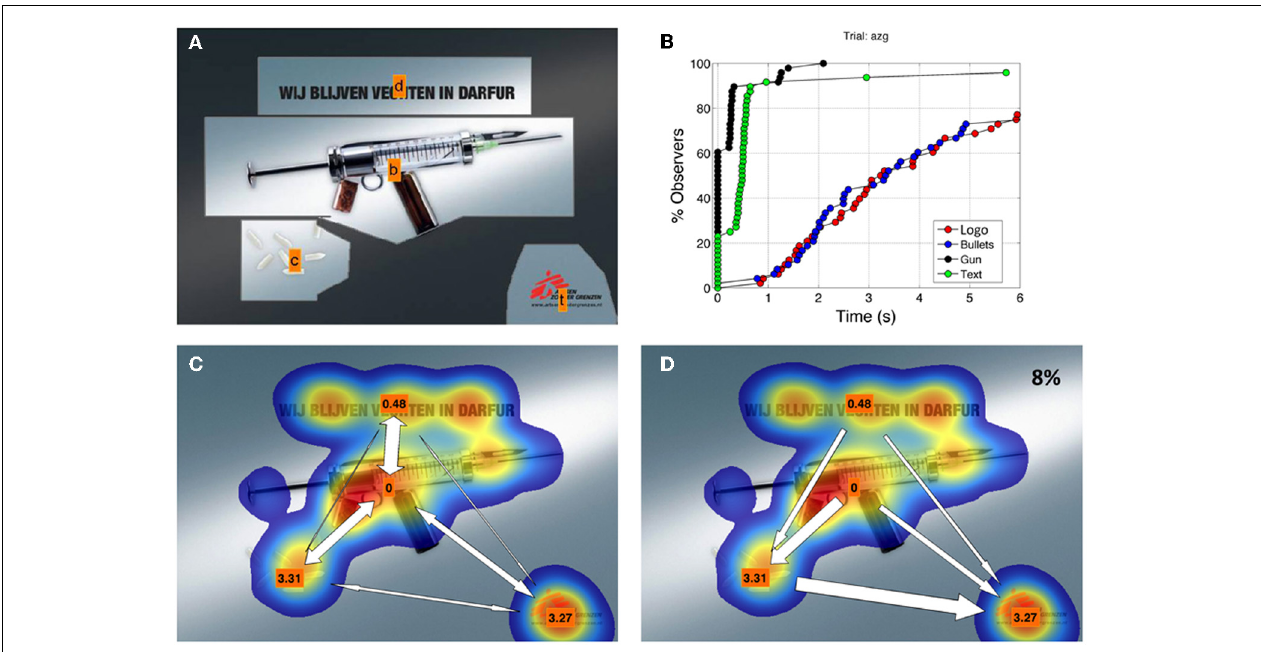
FIGURE 8 | Panel (A) Hand drawn AOIs. The shape and size of the AOI are not very critical in sparse displays. Panel (B) Cumulative plots for 4 AOIs of panel (A) . Cumulative curves for AOI-Text and AOI-Gun are steep with high fixation scores (100 and 98%) and short T 50 (0s and 0.48s). Panel (C) shows visualization of the total transition matrix. The